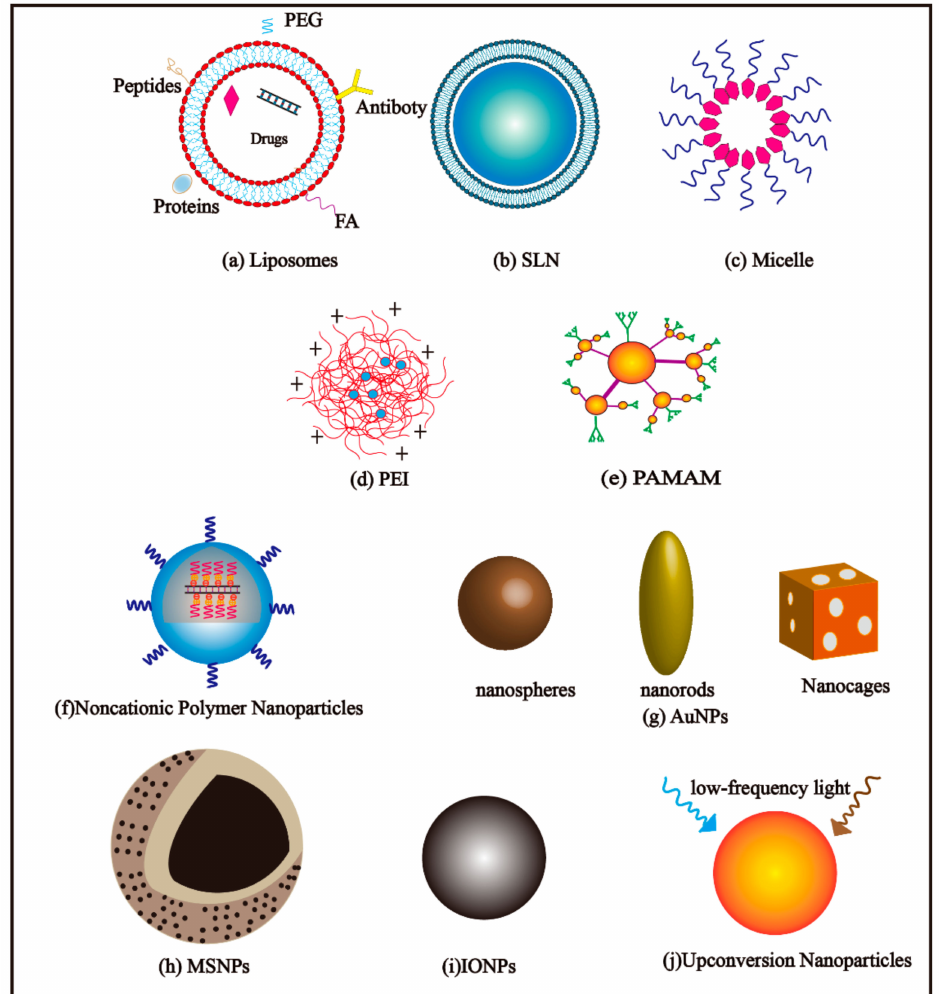
Figure 2. Schematic images of each representative nanoparticle delivery system. ( a ) Liposomes; ( b ) SLN; ( c ) Micelle; ( d ) PEI; ( e ) PAMAM; ( f ) Noncationic Polymer Nanoparticles; ( g ) AuNPs; ( h ) MSNPs; ( i ) IONPs; ( j ) Upconversion